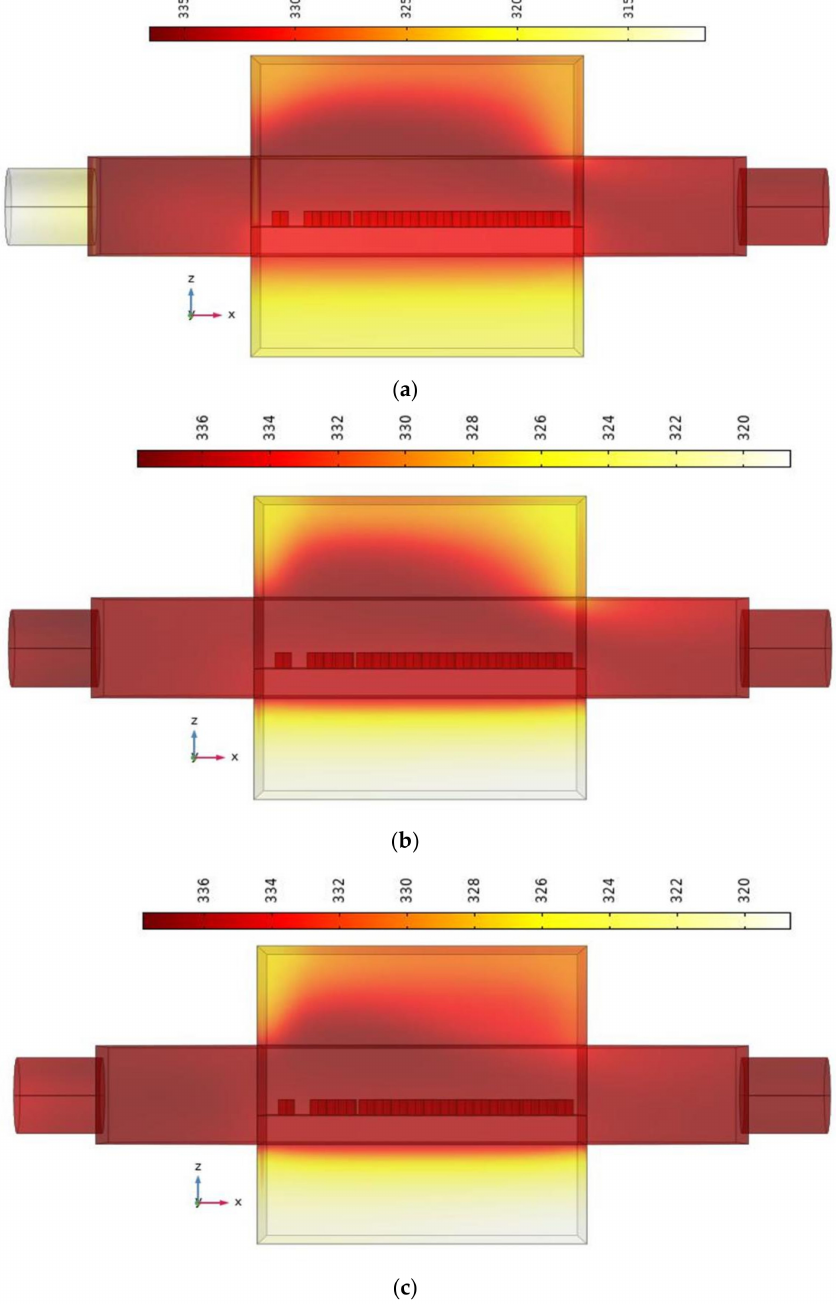
Figure 10. Iso surface temperature distribution at the end of the thermal storage charging process in the presence of pin-fins. ( a ) Re = 50, ( b ) Re = 100, ( c ) Re =